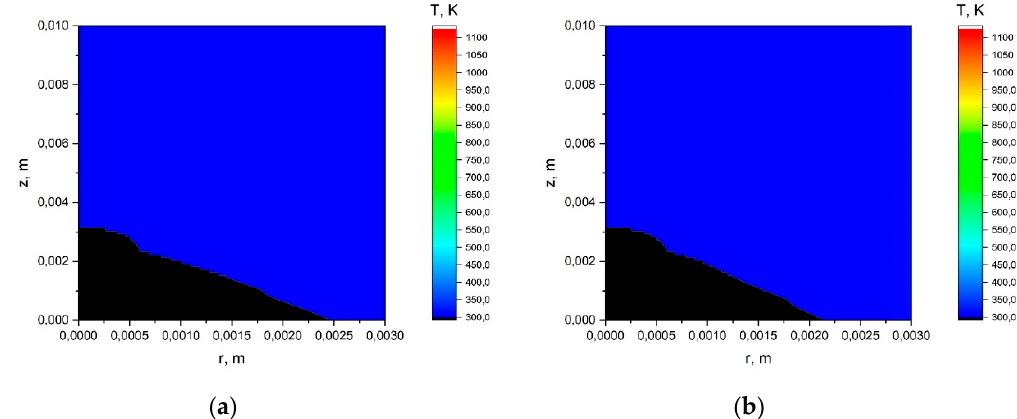
Figure A10. Temperature distribution in the stem of a herbaceous plant: R = 0.003 m, t = 0.5 s, q = 0.5 kW/m 2 ( a ); R = 0.003 m, t = 0.5 s, q = 3 kW/m 2 ( b ).